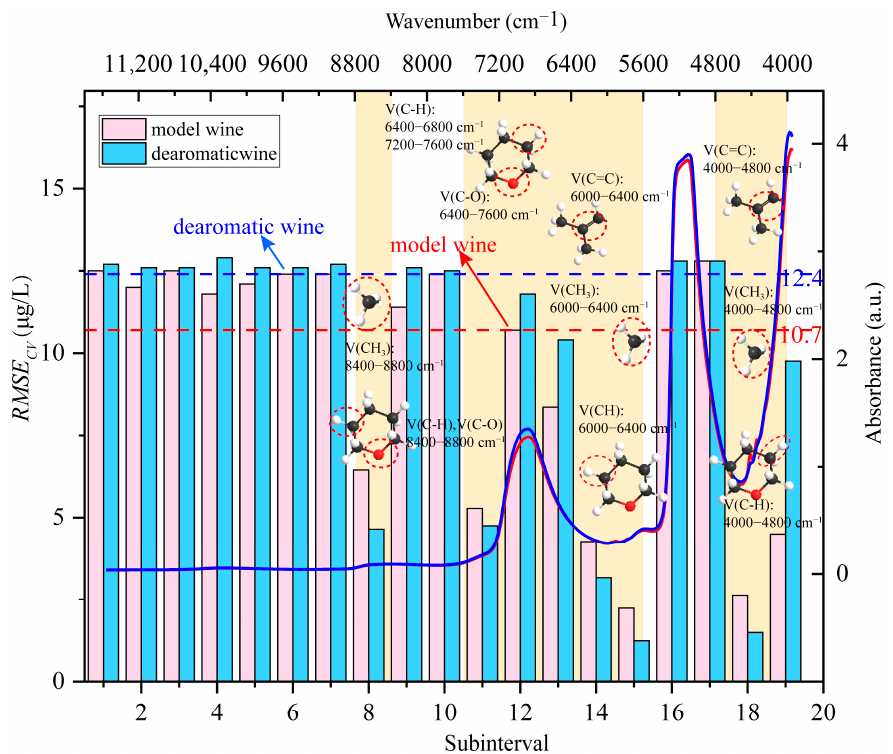
Figure 4. The RMSE CV values of Si-PLS based on each subinterval, and the feature wavebands analysis for the functional groups.